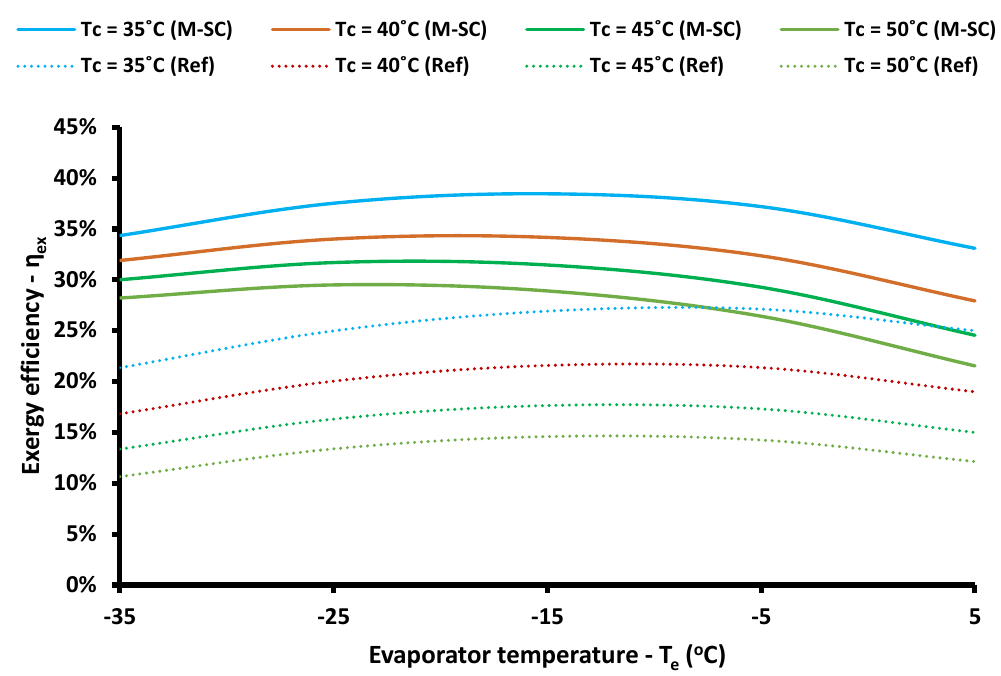
Figure 9. The exergy efficiency of the mechanical subcooling system compared to the reference case for all the examined optimized scenarios.